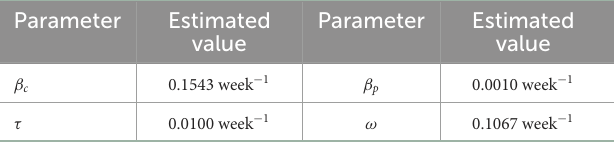
TABLE 4 Baseline values of fitted (estimated) parameters of the model (Equations 1–4), obtained by fitting the model with the weekly crime data for Illinois for the period July 1st, 2021 to June 30th,